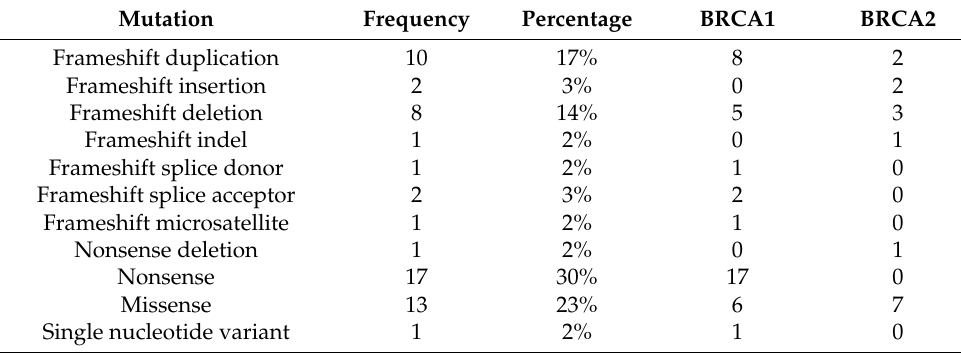
Table 7. BRCA1/2 mutations in the OC group.